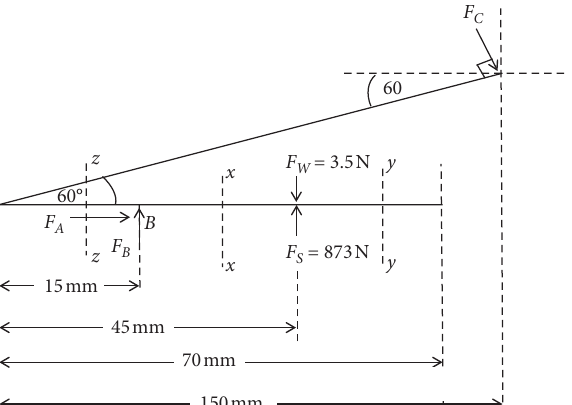
Figure 6: Free body diagram of the device in an operative mode.